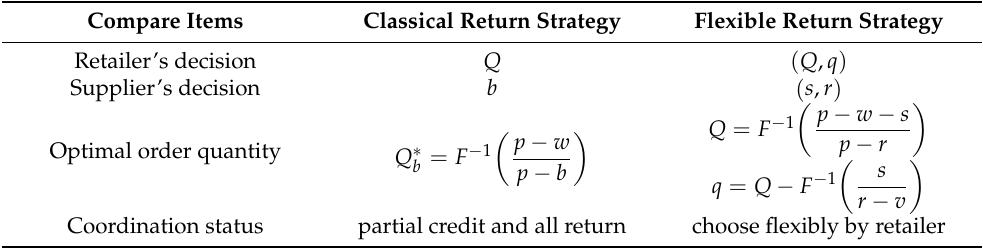
Table 2. Flexible return strategy compared with the classical return strategy.